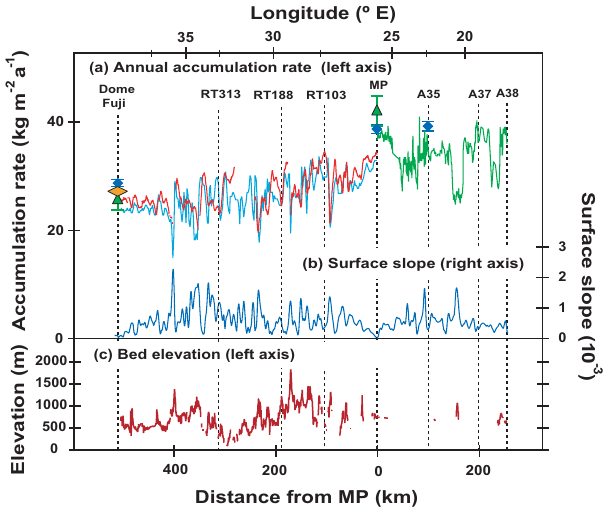
Fig. 4. Annual accumulation rate over various time scales are shown with indicators of the depositional environment along the south route. Again, surface slopes and bed elevation are shown as in Fig. 3. The abscissa indicates distance from MP along the tra- verse route. All other items and symbols are the same as in Fig. 3. Fluctuations of the accumulation rate and surface slope are much larger than those along the route in the main ice